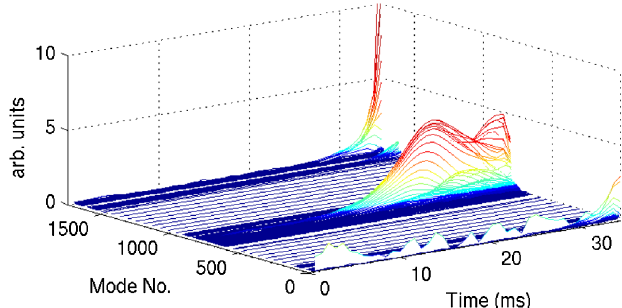
VIDEO 2. The animation shows the system behavior for a different 35 ms of operation of the HER at similar conditions as Video 1. While excited in a manner leading to saturation of the control path, this transient ends with the feedback system regaining control with no loss of the